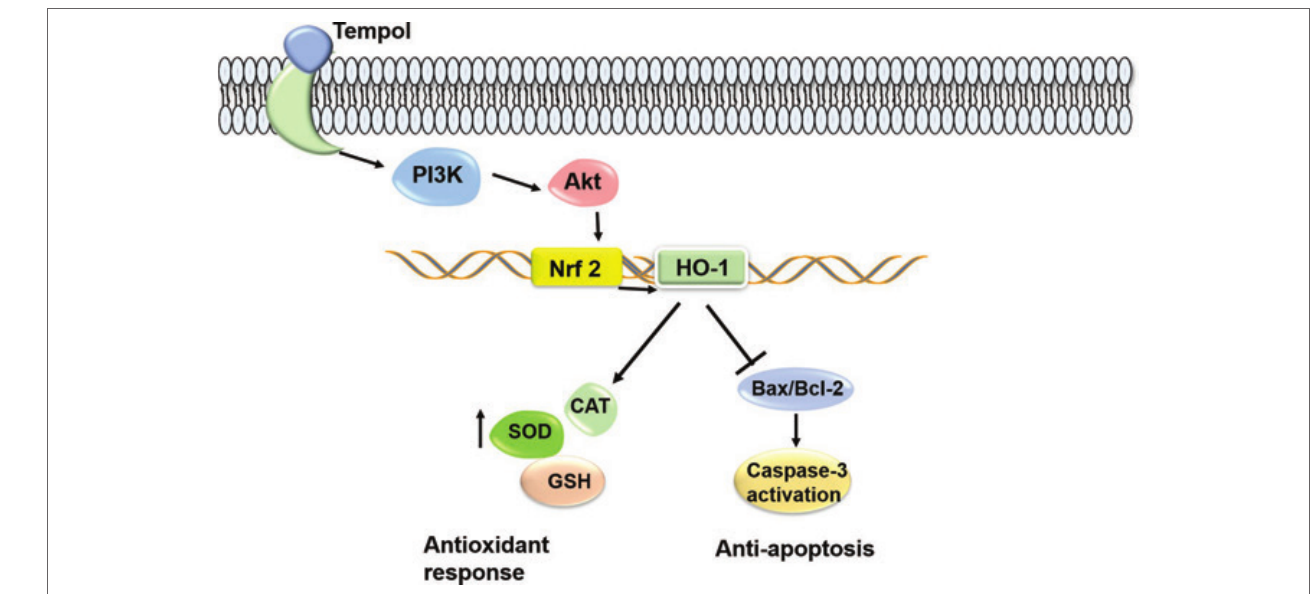
FIGURE 5 | The proposed mechanism for the protective effect of tempol against acetaminophen-induced acute hepatotoxicity in mice. Tempol administration in APAP-induced acute hepatotoxicity mice normalizes liver function via activating PI3K/Akt/Nrf2 pathway, thus increasing antioxidant proteins and inhibiting hepatic